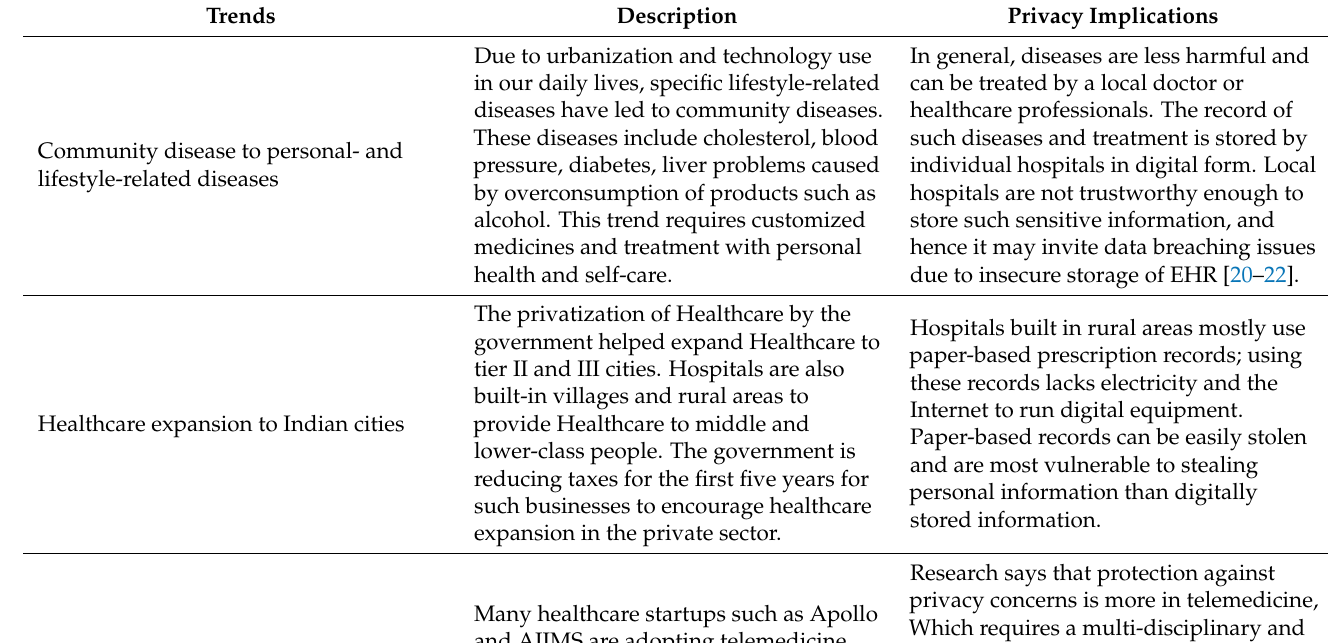
Table 3. Comprehensive overview of ‘trends and privacy implications in the Indian healthcare